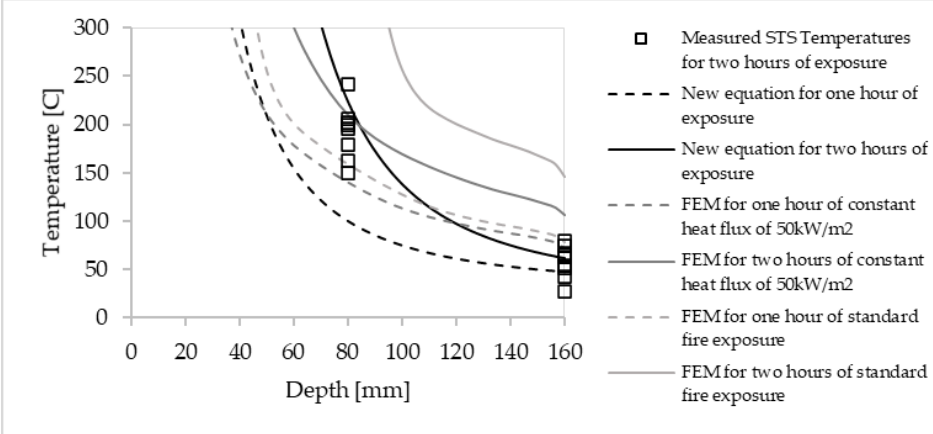
Figure 17. Measured temperatures of FEM and temperature profiles calculated according to equa- tions for unprotected fastener head exposed under standard fire curve up to two hours of fire expo-